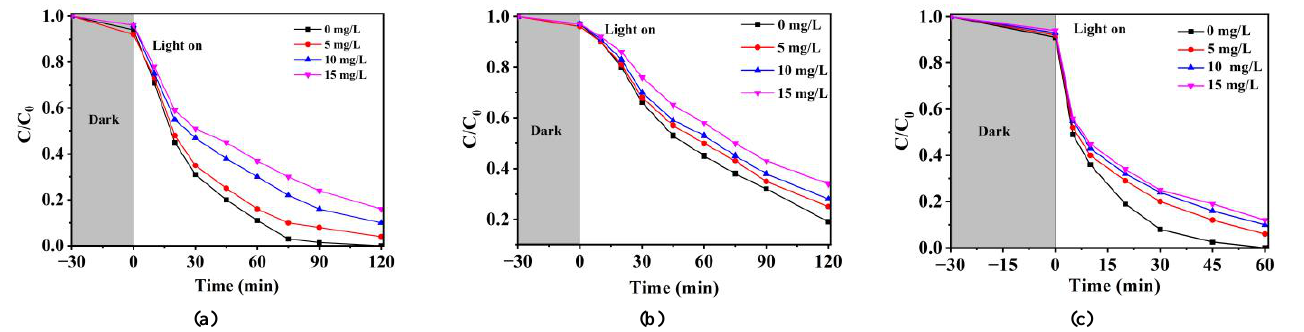
Figure 4. Effect of HA on the degradation efficiency of ( a ) NOR, ( b ) SMX and ( c ) TCH by Ag/CNQDs/g-C 3 N 4 (25 °C, photocatalyst dosage = 0.2 g/L, antibiotic concentration = 10